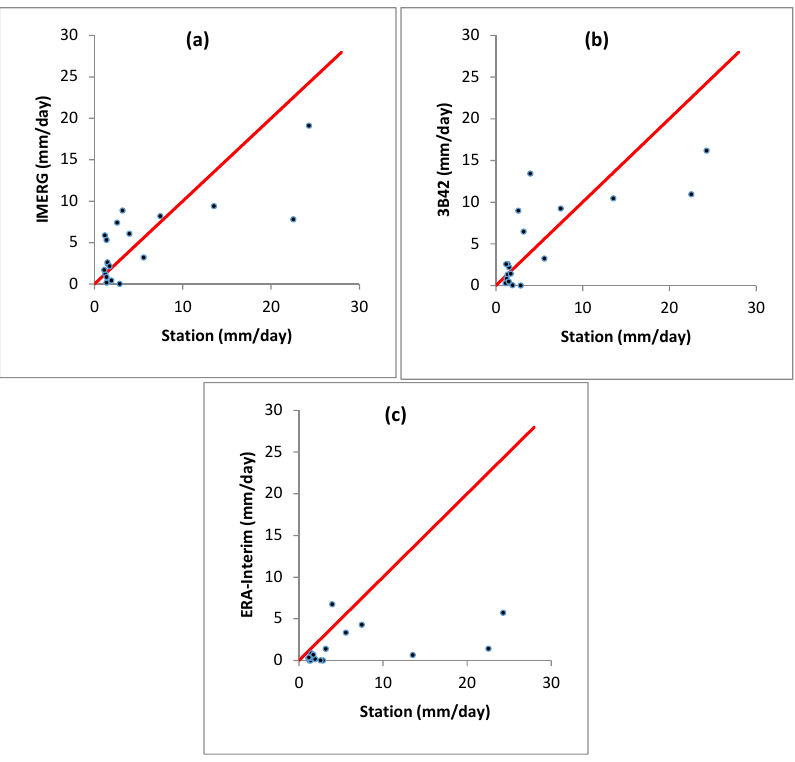
Figure 5. Daily precipitation events scatter plots for Bushehr of IMERG ( a ); 3B42 ( b ) and ERA-Interim ( c ) against gauge data (mid-March 2014 to February 2015).